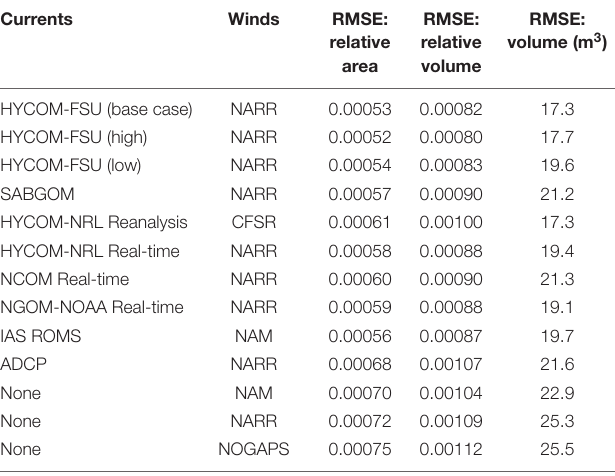
TABLE 1 | RMSE (mean over all dates) comparing modeled to remote sensing data for floating oil distributions, varying currents and winds used as input. Currents Winds RMSE: